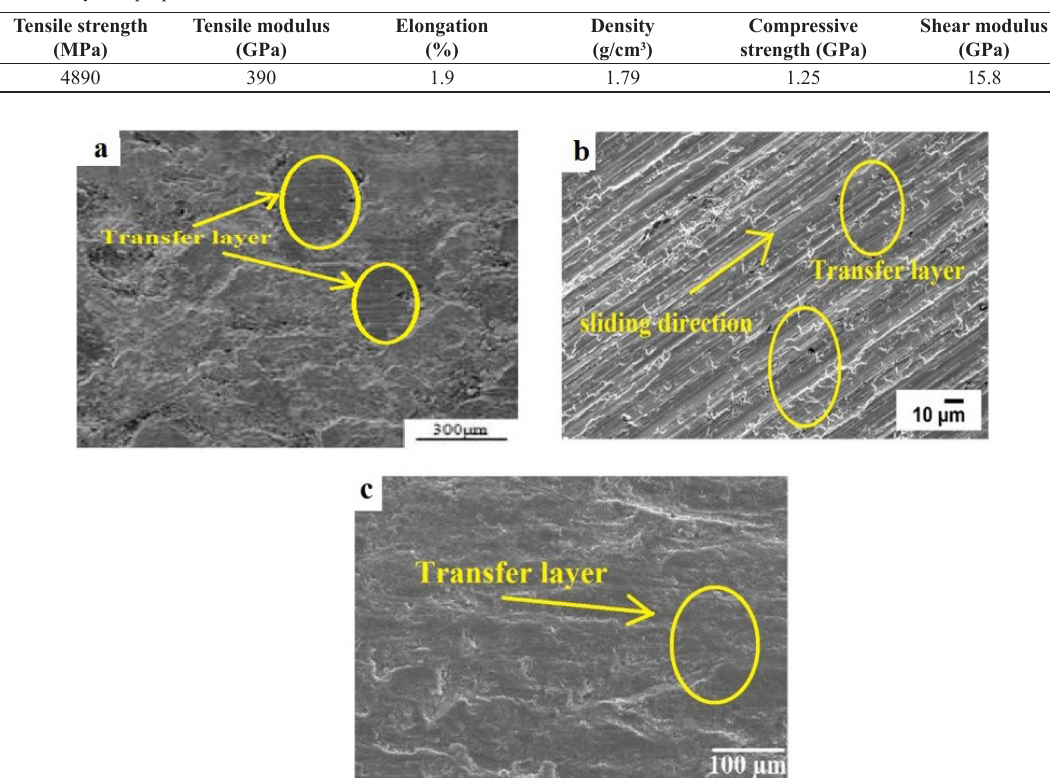
Figure 2. Transfer layers formed on stainless steel at 29.43 N for the material (a) UFPE, (b) SF (c)